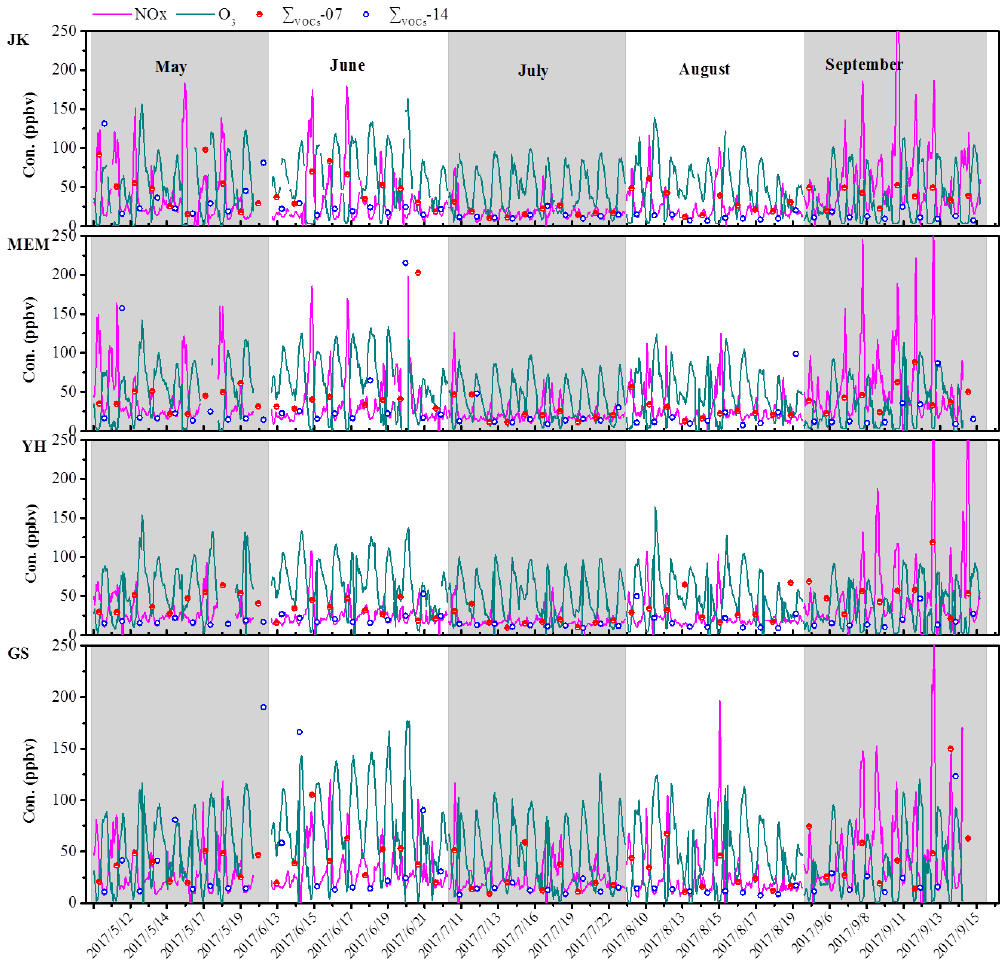
Figure 6. Temporal variations of mixing ratios of (cid:54) VOCs , NO x and O 3 at the four sites during the whole sampling period; (cid:54) VOCs -07 stands for the concentration level of (cid:54) VOCs observed at 07:00LT, and (cid:54) VOCs -14 was that observed at